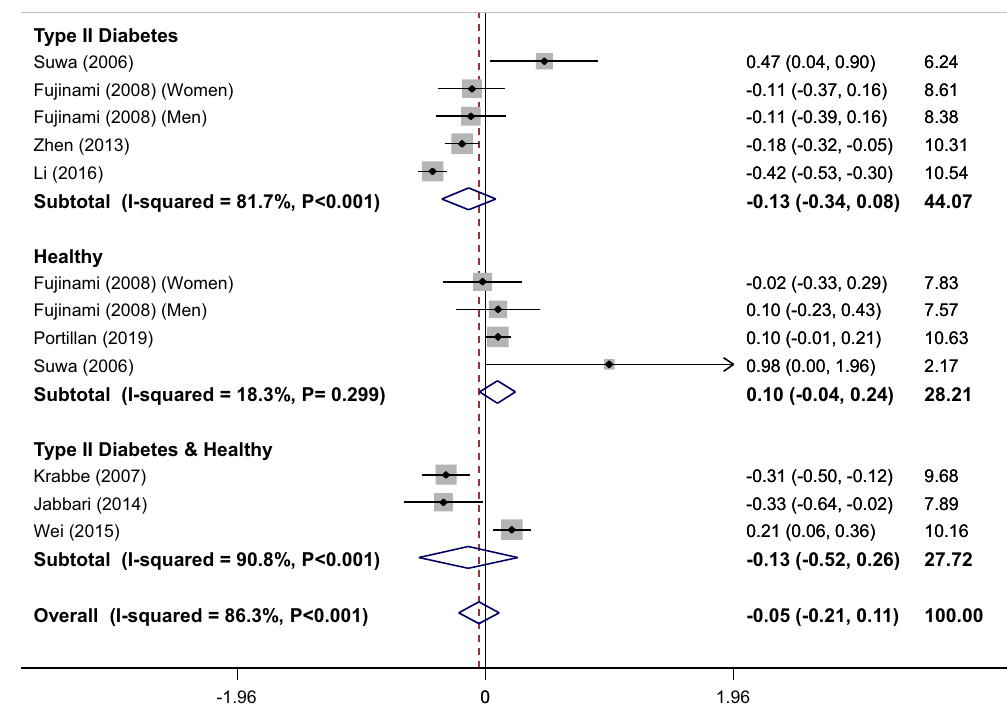
Figure 3. Forest plot of correlation between serum/plasma BDNF levels and fasting blood glucose (FBG); stratified by health status of